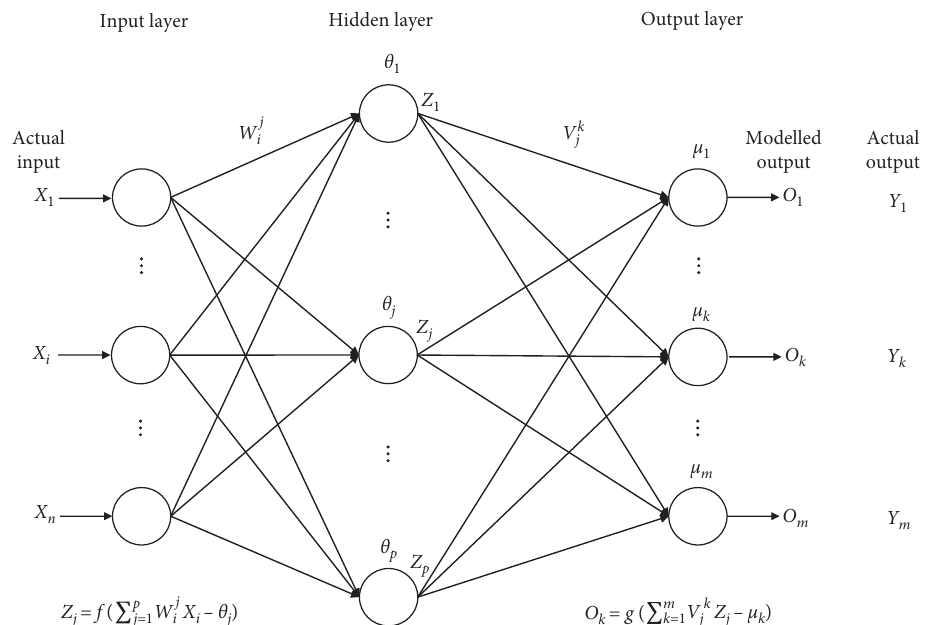
Figure 2: The structure of the BPANN model. The number of neurons of each layer is denoted as n , p , and m , respectively. W j and j � 1, 2, ... , p ) represents the weights between the input and hidden layer, while V k j ( j � 1, 2, .. . , p and k � 1, 2, ... , m ) represents the weights between the hidden and the output layer. The threshold values of the hidden layer and the output layer are θ j and μ k , respectively. f ( · ) is an activation function by which the mapping process from the input layer to the hidden layer is implemented and g ( · ) is an activation function by which the mapping process from the hidden layer to the output layer is implemented. In this study, the default activation functions of the BPANN model in the MATLAB (2016a) ANN toolbox were adopted. The parameters in the BPANN mainly include the maximum training times, learning rate, and training target accuracy. The parameters of the BPANN model in this study include a maximum training time of 2000, a learning rate of 0.5, and a training target accuracy of